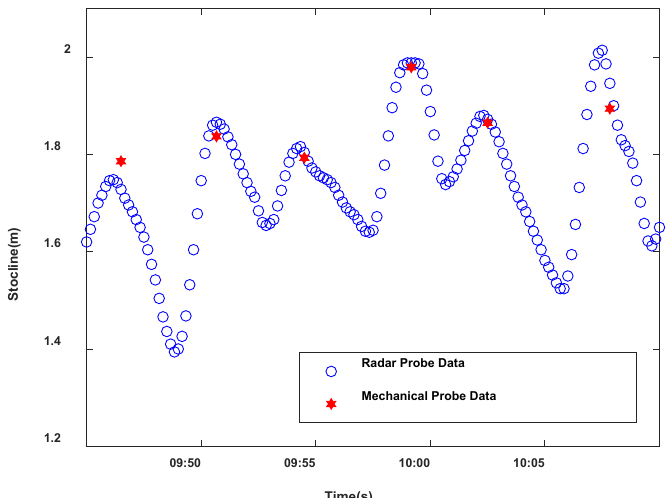
Figure 2. Detection data of radar and mechanical probe.